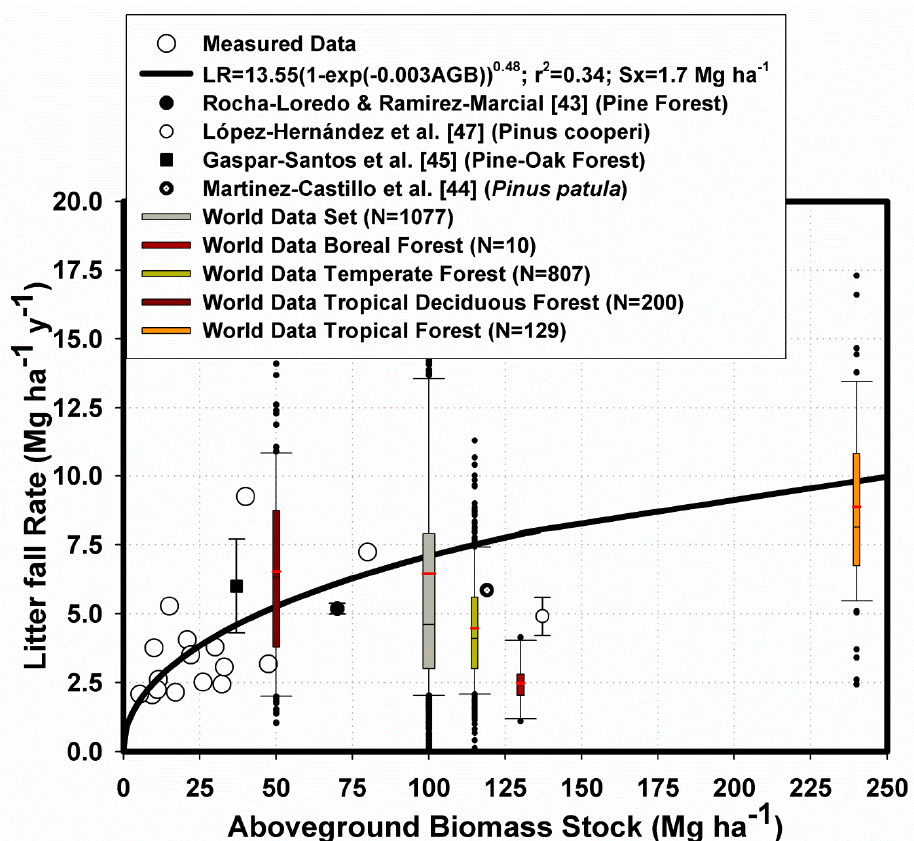
Figure 2. Predicted rates of litter fall as a function of Aboveground Biomass Stock (hollow dots) for northern Mexico’s non-industrial plantations overlapped with some other local, regional, national and World data source (Original local data source: [37] ) .